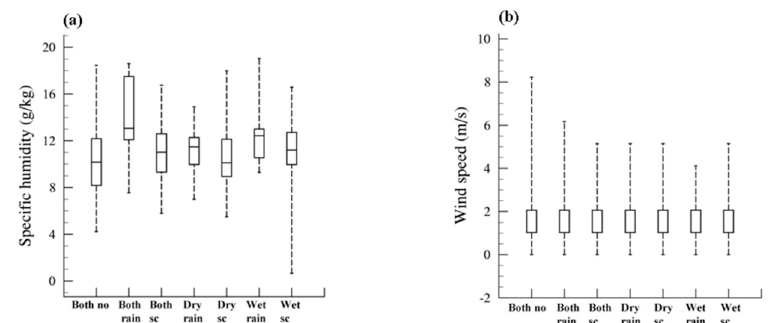
Figure 9. The distributions of near—surface specific humidity and wind speed at initial sounding times based on different model outcomes. The upper and lower of the box show upper quartile and lower quartile, and the line inside represents the median. The upper whisker and lower whisker indicate the maximum and the minimum values in the non-abnormal range, respectively. ( a ): near— surface specific humidity ( b ): near—surface wind